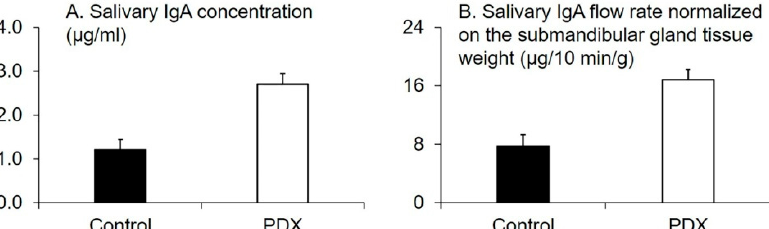
Figure 2. Effects of polydextrose (PDX) addition on the salivary immunoglobulin A (IgA) concentration ( A ) and salivary IgA flow rate normalized on the submandibular gland tissue weight ( B ). n = 6 per group. Data are expressed as means (histogram bars) and SEM (error bars). Salivary IgA concentration and flow rate normalized on the submandibular gland tissue weight in the PDX group were higher than those in the control group ( p = 0.001 and 0.001, respectively, Welch’s t -test).